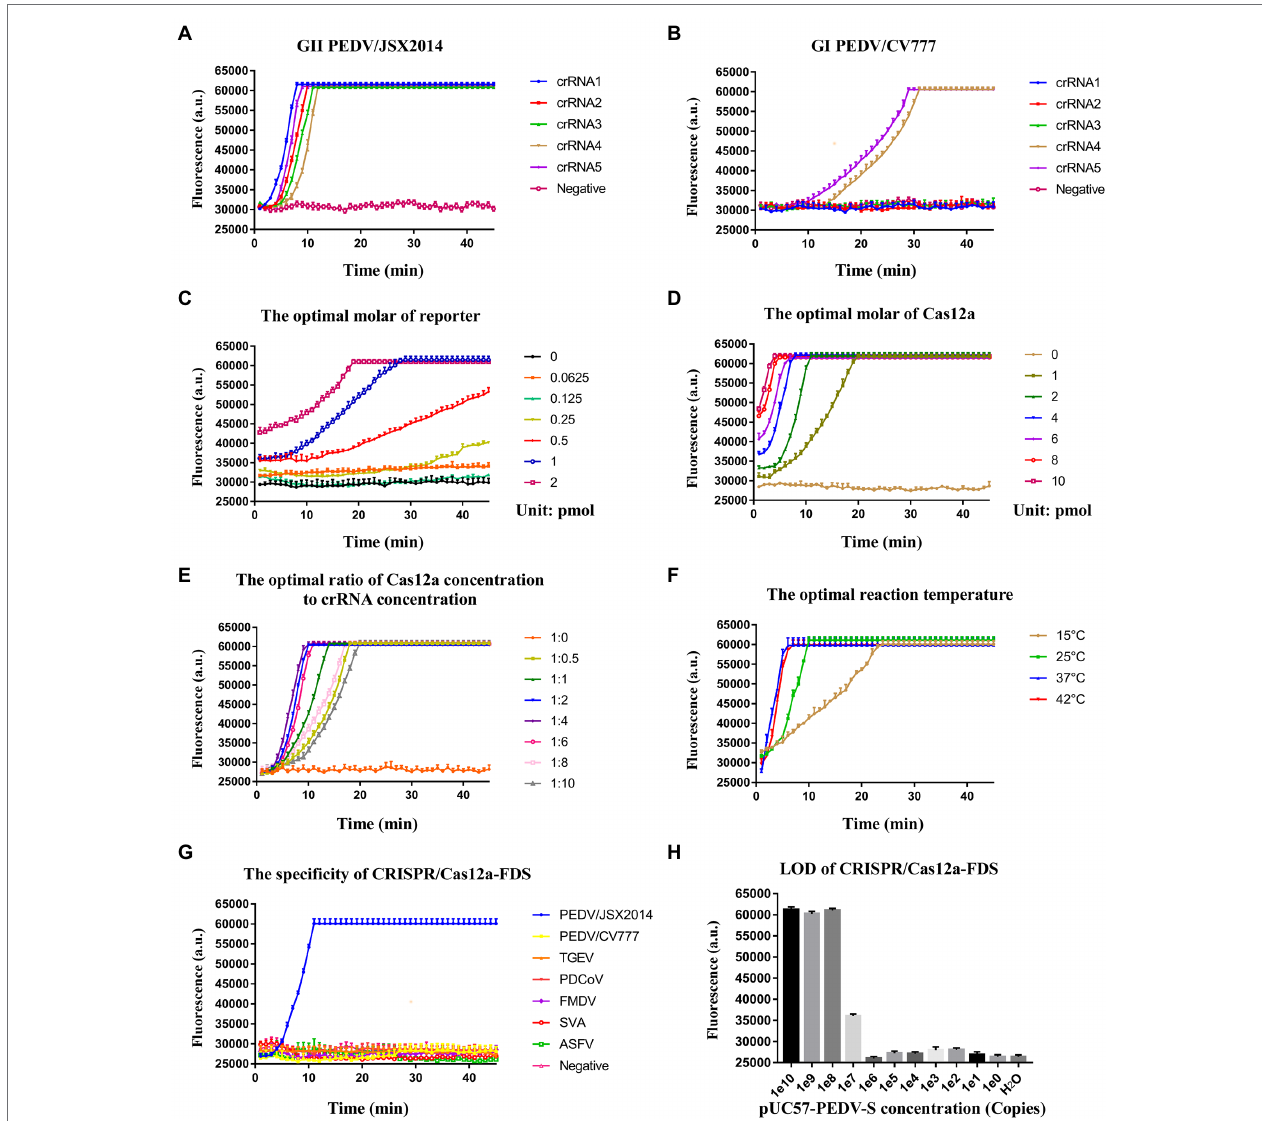
( Figure 3E ). When it surpassed 1:4, the amplification efficiency decreased ( Figure 3E ). Finally, the amplification efficiency at 15 and 25 ° C was significantly lower compare with that at 37 and 42 ° C, whereas the reaction temperature between 37 and 42 °